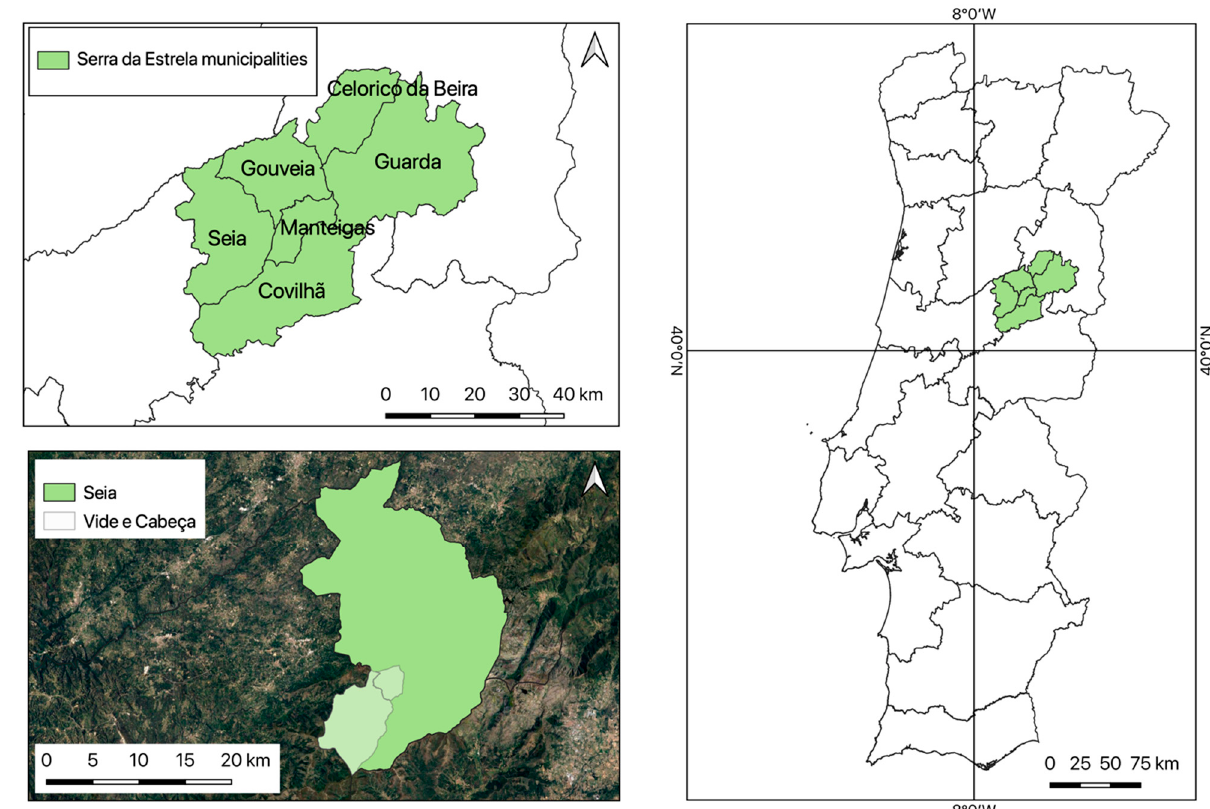
Figure 1. Location of the area selected for sample collection.